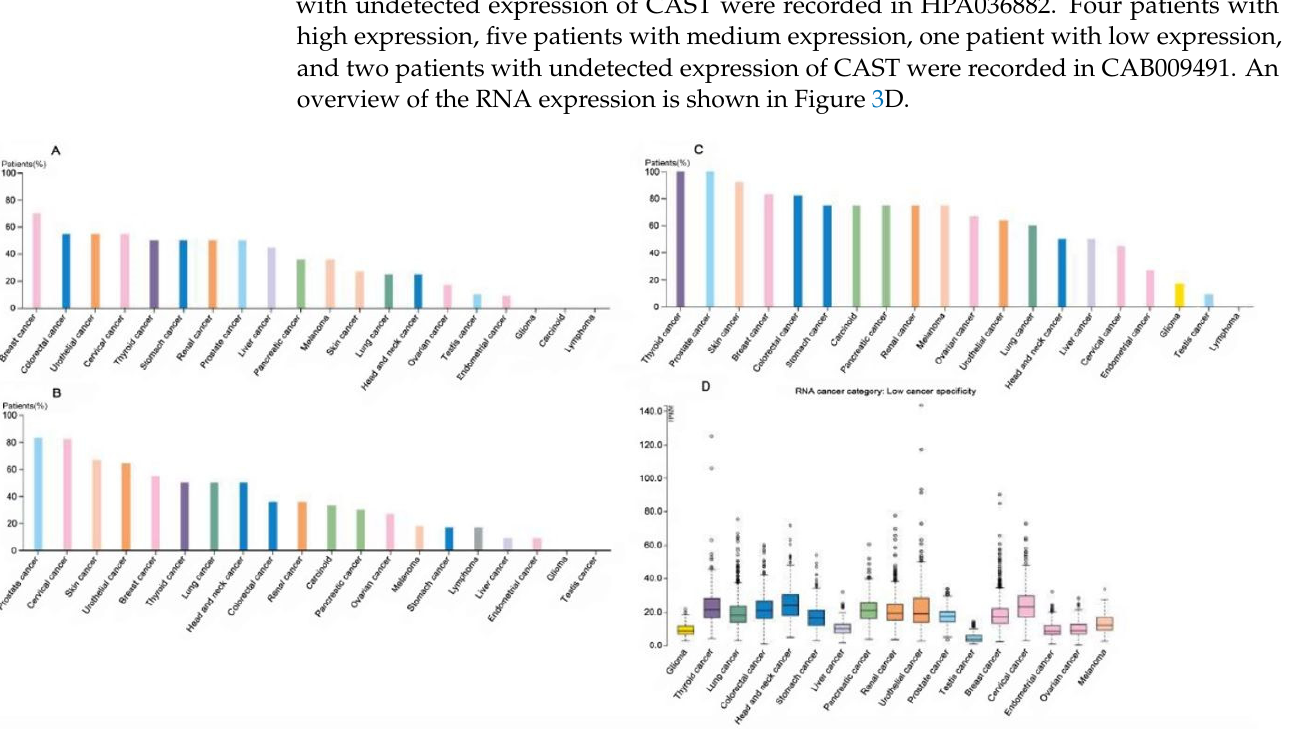
Figure 3. ( A ) HPA036881 protein expression in cancer tissues showing weak to moderate cytoplasmic immunoreactivity. Few cases of basal-cell carcinomas displayed strong immunoreactivity. Lymphomas along with several gliomas and testicular cancers were negative. ( B ) HPA036882 protein expression in cancer tissues displaying weak to moderate cytoplasmic staining with membranous positivity in several cases. Few cases of colorectal, breast, lung, skin, or urothelial cancers were strongly stained. Most cases of gliomas and testicular, liver, and endometrial cancers were negative. ( C ) CAB009491 protein expression in most cancer tissues demonstrated moderate to strong cytoplasmic positivity. Gliomas and lymphomas generally showed weak positivity, while testicular cancers, in most cases, were negative. ( D ) RNA-sequencing data for cancer category from the TCGA.